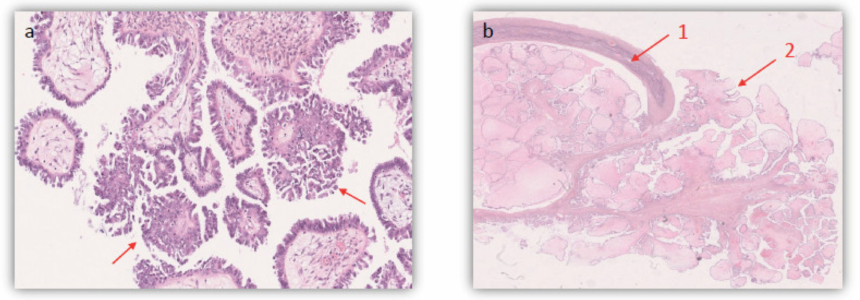
Figure 3. Photomicrography showing histopathologic confirmation of a serous BOT using Hema- toxylin and Eosin on FFPE samples (X25.5) in case 3. ( a ). Arrows show Focal areas of micropapillary pattern ( b ). 1. Endophytic and 2. Exophytic